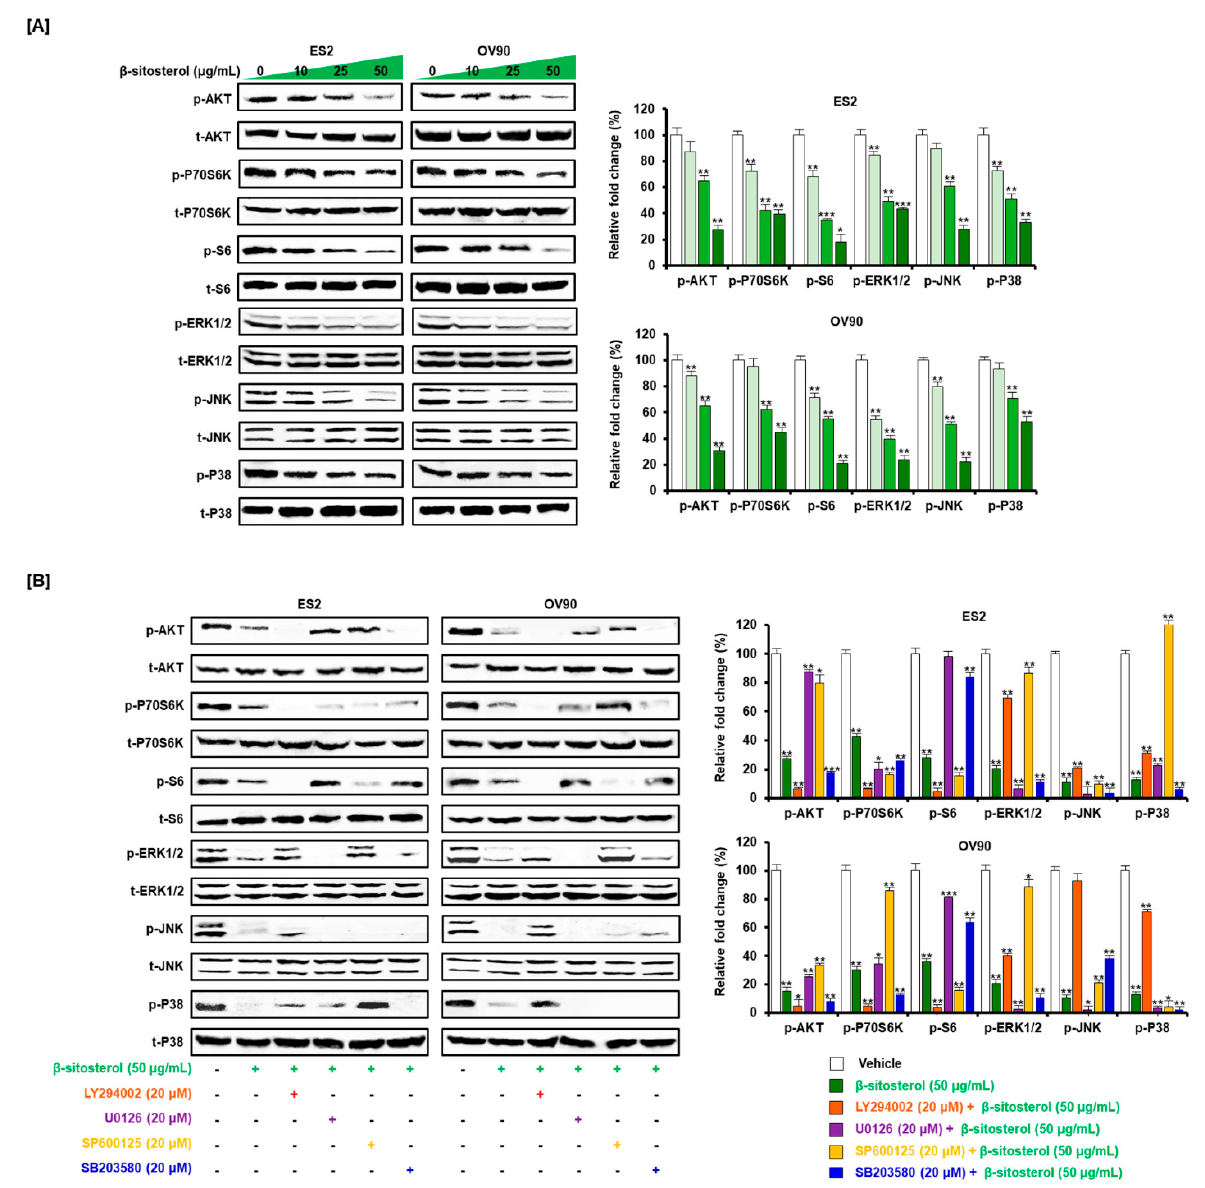
Figure 6. Change of cell growth-related signals by β -sitosterol in the two cell lines. ( A ) Western blots show phosphorylation changes in the PI3K pathway including protein kinase B (AKT), P70S6 kinase (P70S6K), S6 and in the MAPK pathway including extracellular signal-regulated kinase 1/2 (ERK1/2), c-Jun N-terminal kinase (JNK), P38, in ovarian cancer cells after β -sitosterol (0, 10, 25, and 50 µg/mL) treatment. ( B ) Western blots show changes in the phosphorylation levels of proteins in the PI3K and MAPK signaling pathways in ovarian cancer cells following co-treatment with β -sitosterol and each inhibitor. The asterisks indicate significant differences between treated and control cells (*** p < 0.001, ** p < 0.01, and * p < 0.05).